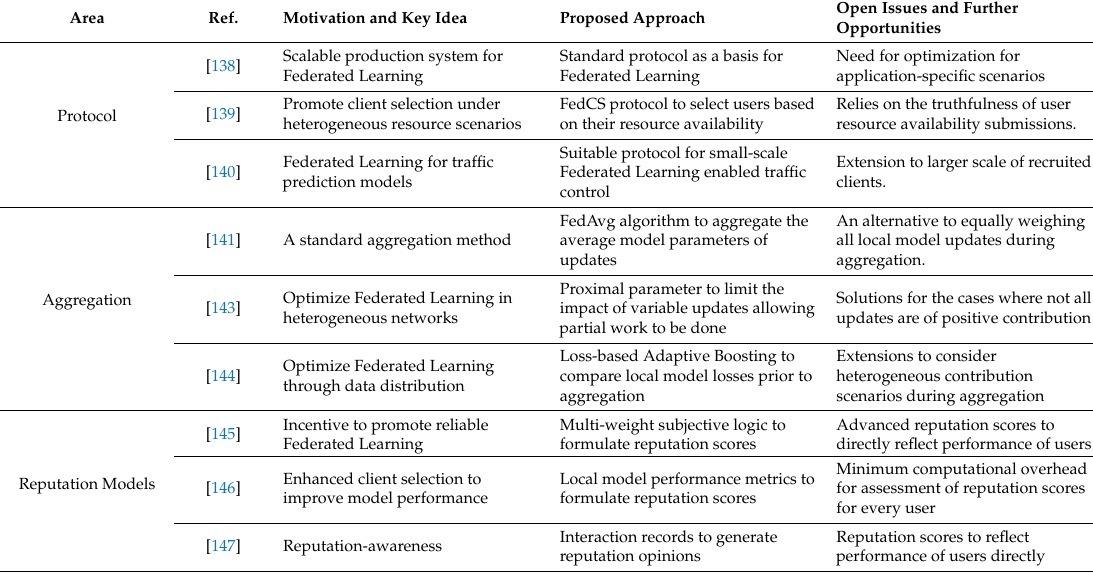
Table 1. Overview of Federated Learning Research covered with key ideas, methodologies, open issues and opportunities for future